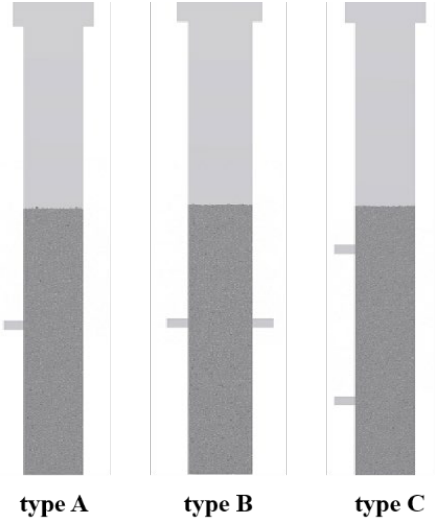
Figure 12. Structure diagram of different feeding structures.